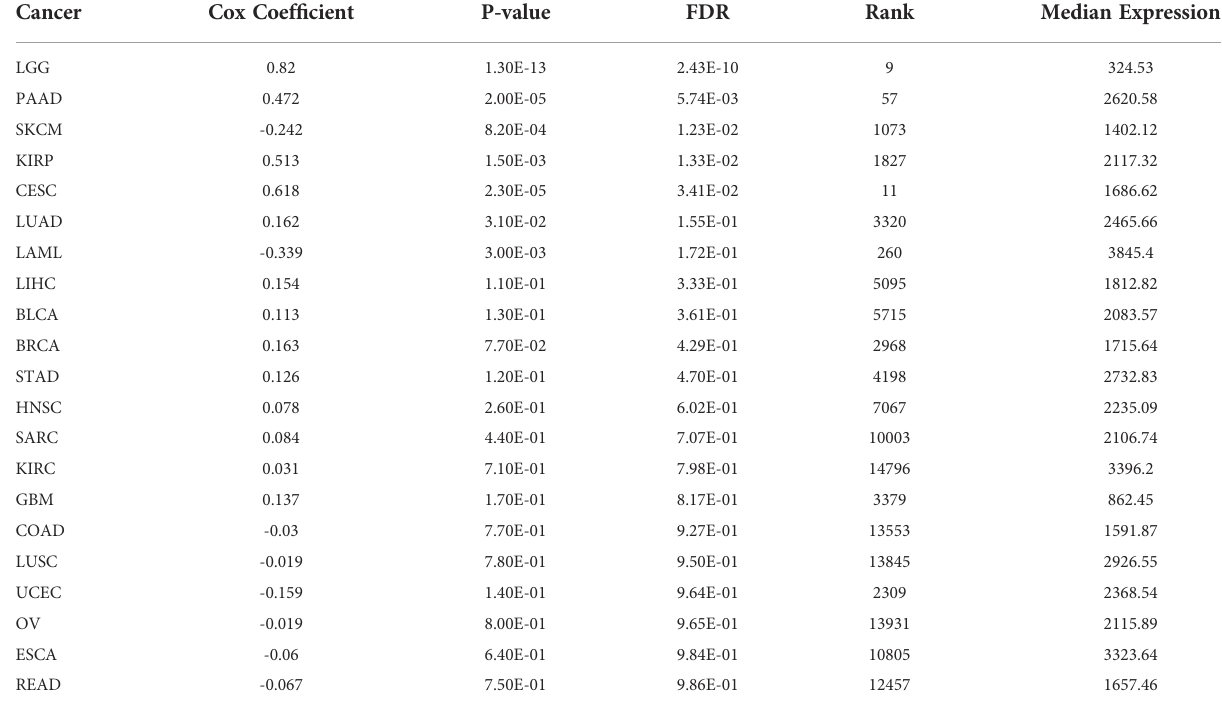
TABLE 1 Cox regression results of FNDC3B among 21 tumor types.